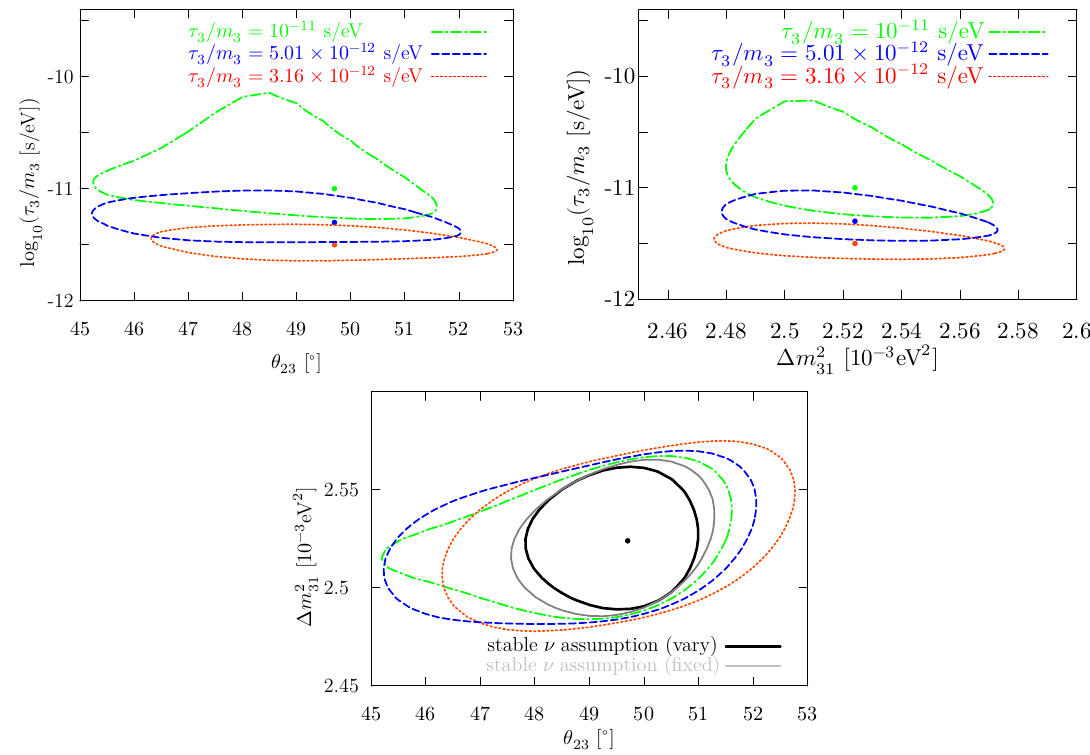
Figure 9 . The exclusion contour at 3 (cid:27) on the planes any two of log and (cid:1) m 2 (right). We show for di(cid:11)erent true values: (cid:28) 3 =m 3 = 10 (cid:0) 11 (dashed-dotted green), 31 5 : 01 (cid:2) 10 (cid:0) 12 (short-dashed blue) and 3 : 16 (cid:2) 10 (cid:0) 12 (dotted red) s/eV. In the lower panel, we